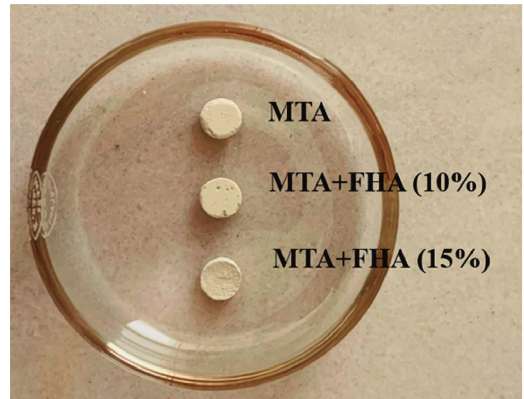
Figure 1: The samples were prepared in three study